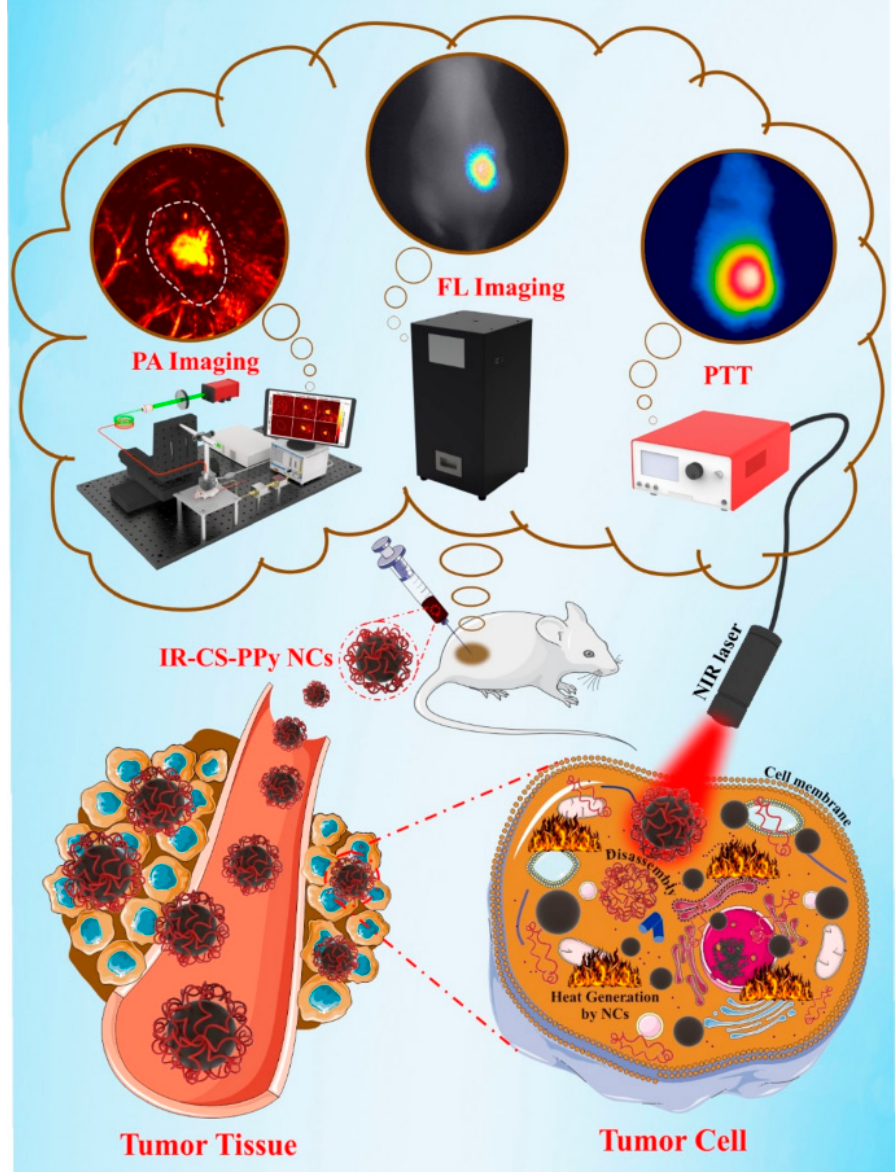
Figure 6. Dual-channel photoacoustic/fluorescence imaging-guided photothermal treatment using IR-CS-PPy NCs, reprinted from [180].